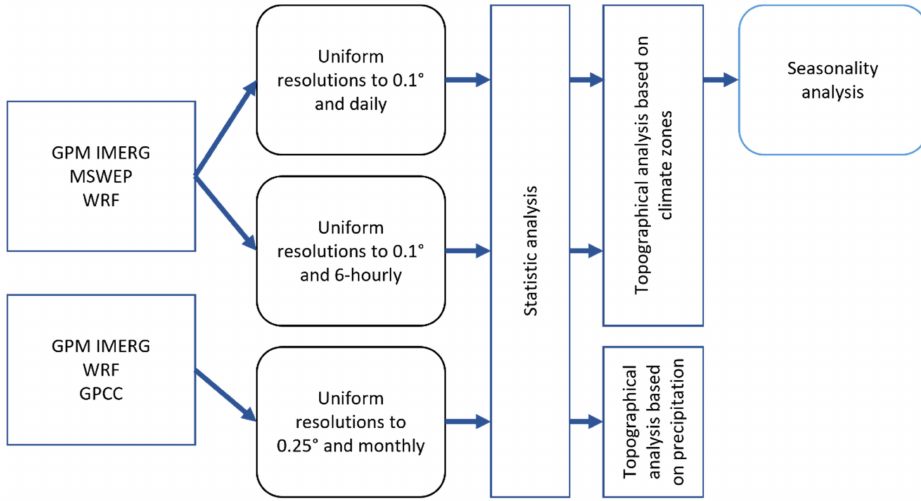
Figure 2. The schematic flowchart of the analysis in this